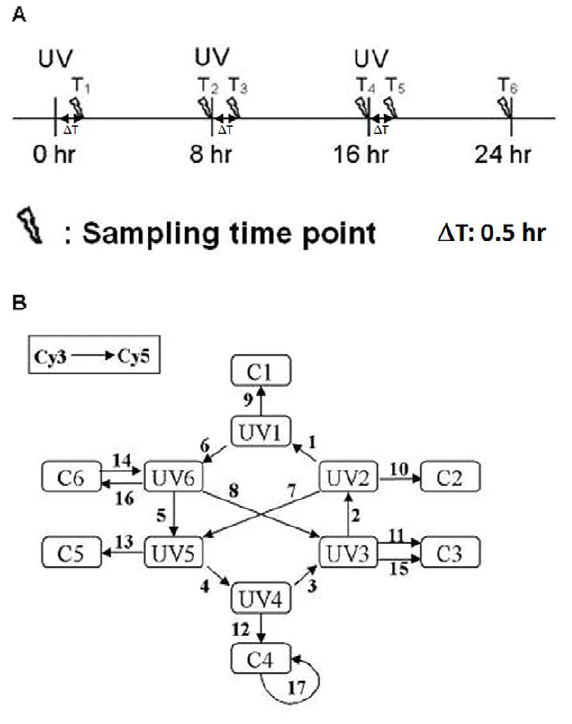
Figure 1. UVB stimulation and microarray experimental design. A ) Three UVB exposures are indicated by UV at 0, 8, and 16 hours. T 1–6 denote the sampling time points. T 1, 3, 5 are timed 30 minutes after the corresponding UVB irradiation. T 2, 4, 6 are timed 8 hours after each UVB irradiation. At each sampling time point, two samples (control and UV- irradiated) were collected. B ) Seventeen dual-color microarray slides, each represented by an arrow, are used to measure the expression levels of the 12 samples. UVi/Ci denotes the UV-irradiated/control sample harvested at time T i . Samples appearing at the tail/head of an arrow are labelled with Cy3/Cy5. Slides no. 14 and 16 are dye-swap hybridizations. Slides no. 11 and 15 are technical replications. Slide no. 17 is a mock